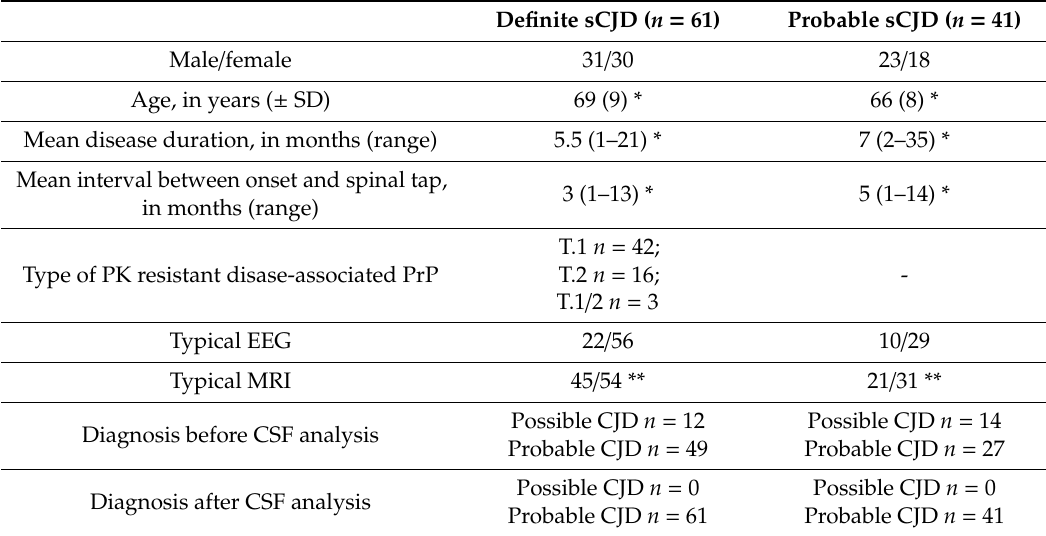
Table 1. Summary of probable and definite sporadic Creutzfeldt–Jakob disease (sCJD).